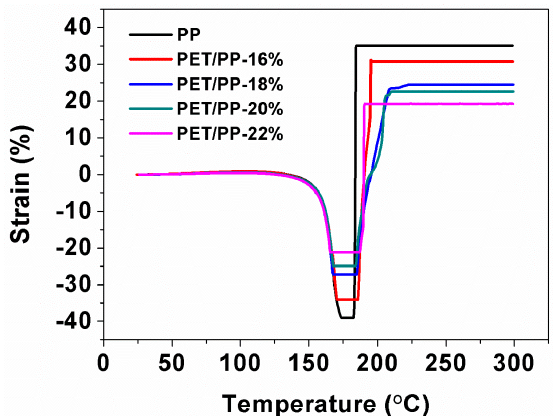
Figure 8. Thermomechanical behavior of the PP separator and PET/PP separators.